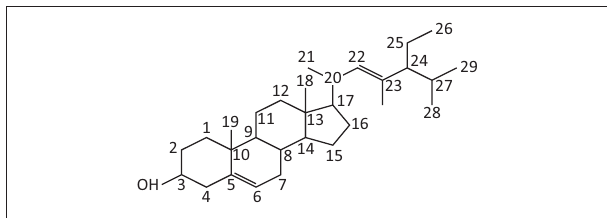
FIGURE 1: Stigmasterol (Stigmast-5, 22-dien-3β-ol) C